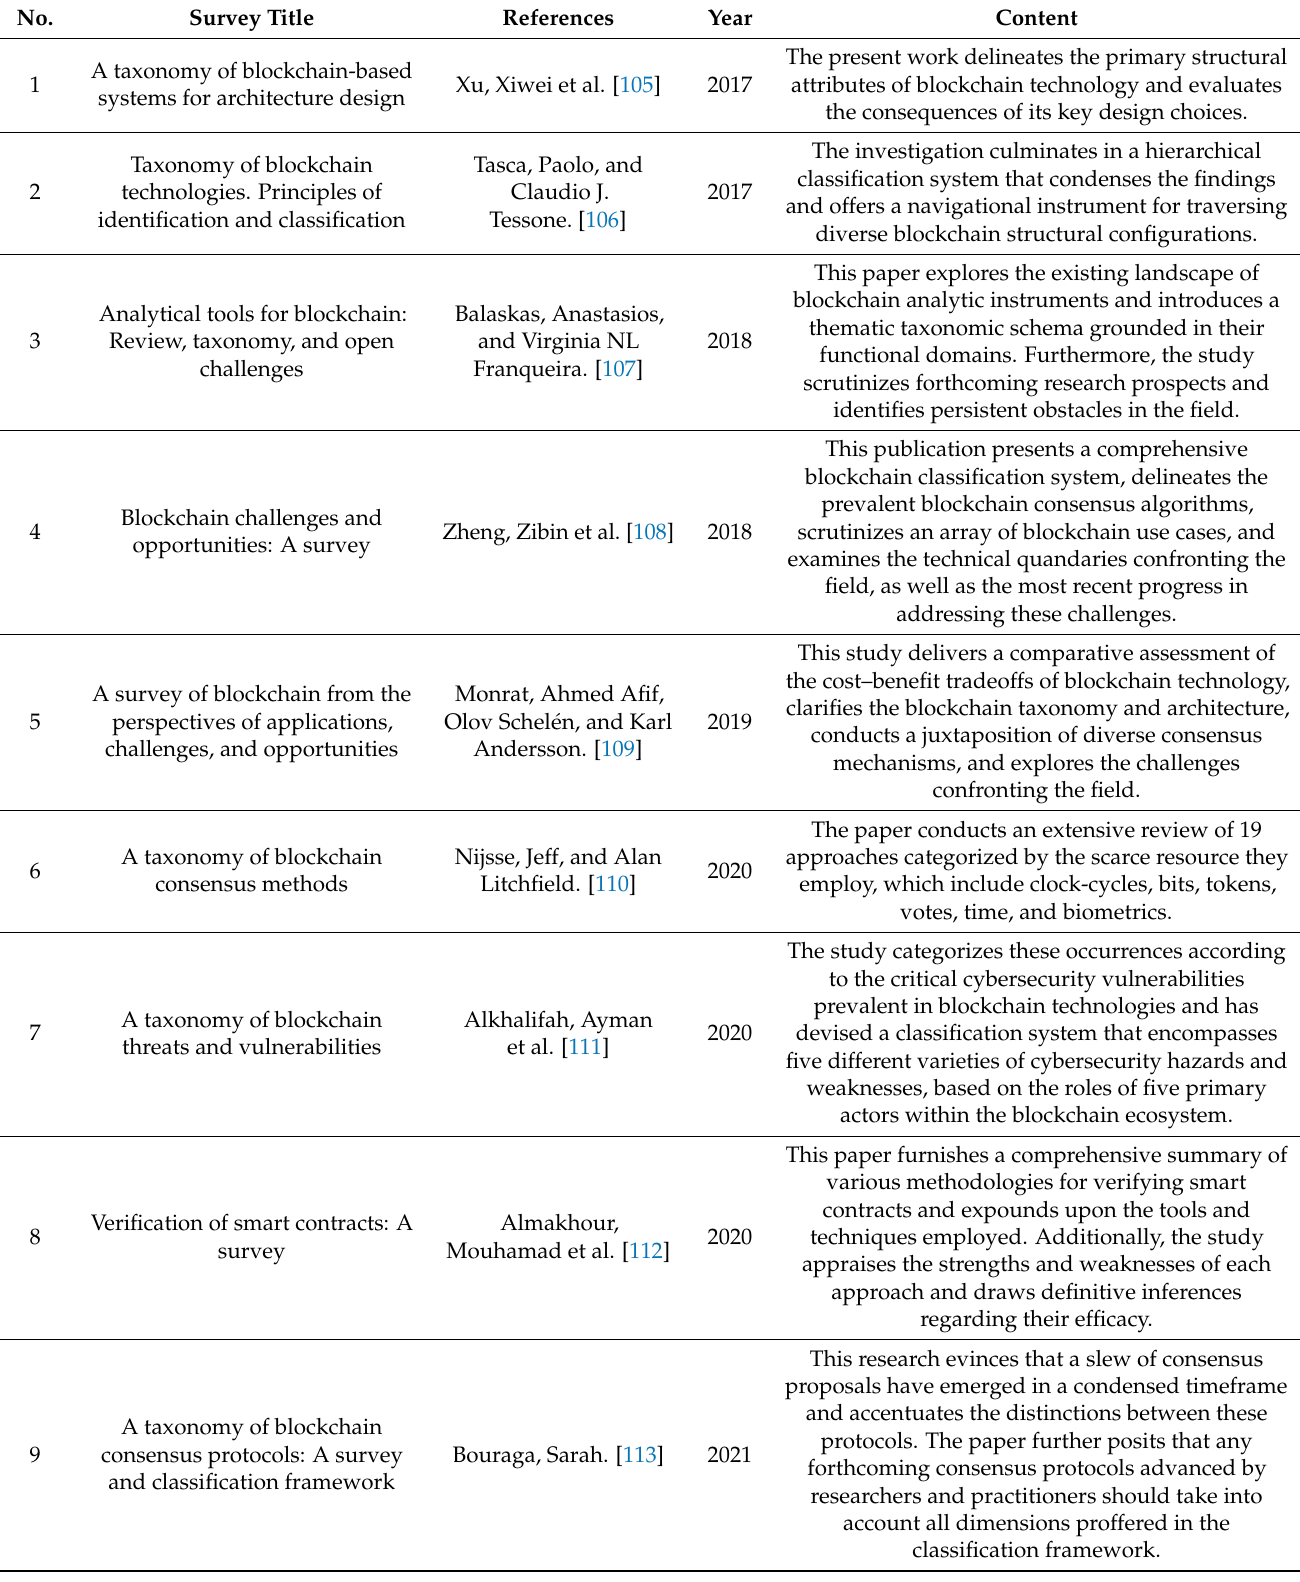
Table 3. Synopsis of blockchain taxonomies in the decade following